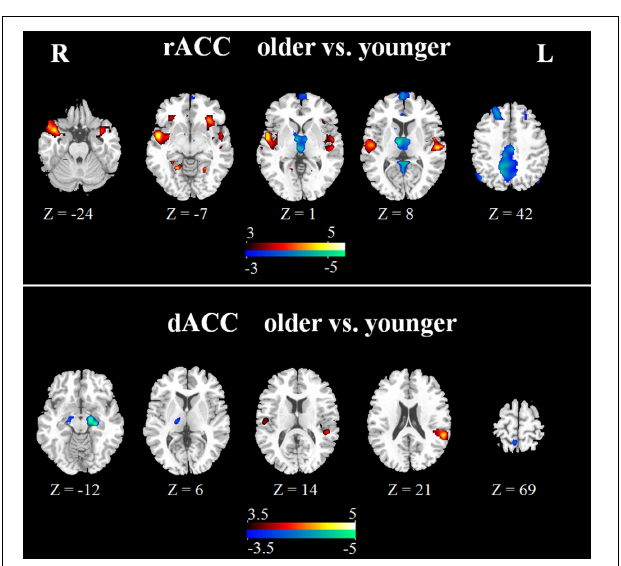
FIGURE 3 | Significant differences of rACC (upper) and dACC (lower) between the two groups. Compared with younger adults, both increased (hot) and decreased (cool) connectivity was observed. The statistical threshold was P < 0 . 05 (FDR-corrected, k = 23 adjacent voxels).